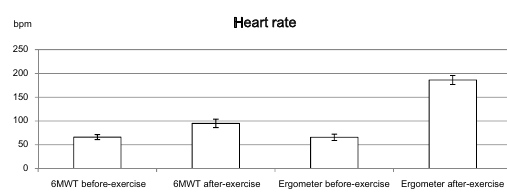
Figure 2. The relative activity ratio of plasma glutathione peroxi- dase (GPx) to superoxide dismutase (SOD) increased by 37% (p<0.05) after vitamin administration. Dotted lines indicate values of each subjects and solid line indicates means ± SE.